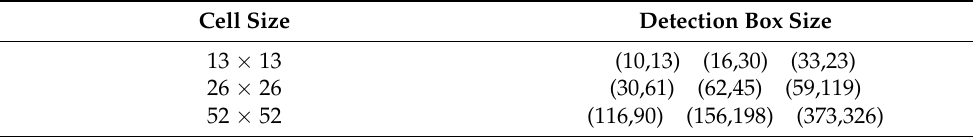
Table 1. YOLOv3 Anchor